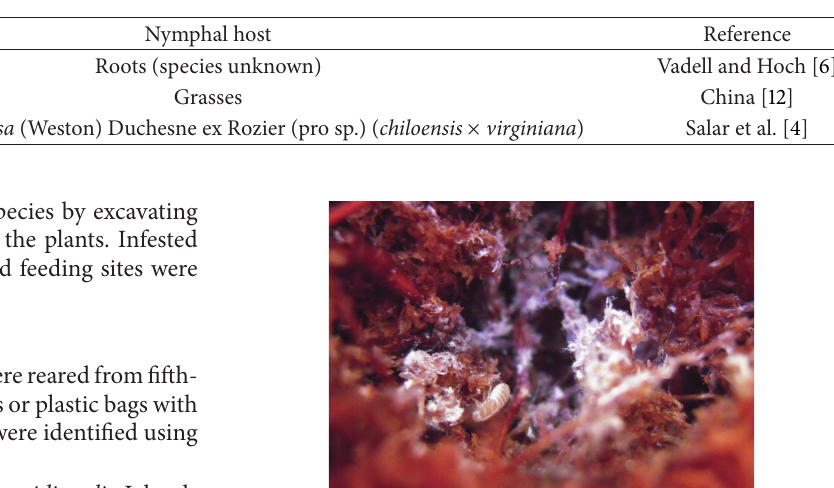
Table 1: Known nymphal hosts of Cixius species.